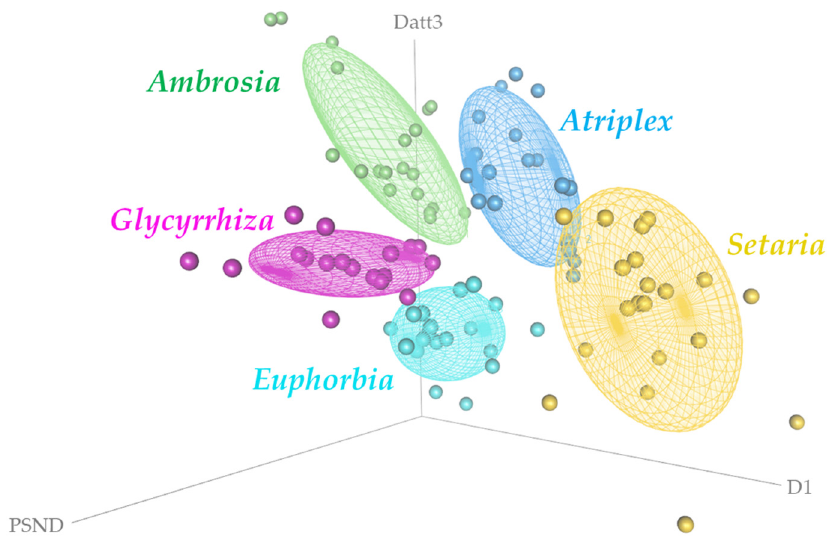
Figure 8. Ambrosia artemisiifolia , Euphorbia seguieriana , Atriplex tatarica , Glycyrrhiza glabra и Setaria pumila in the range of VIs D1, Datt3, and PSND.